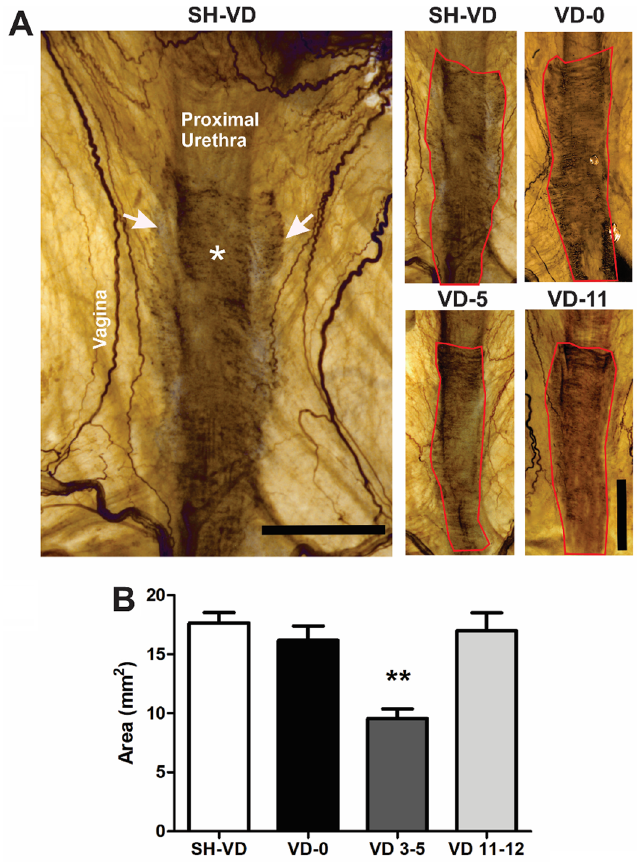
Figure 4. Urogenital tract of rats showing injury and recovery of cholinergic innervation in the urethra after vaginal distension (VD). ( A ) Photos of the urogenital tissue treated with acetylcholinesterase (AchE) histochemistry in a ventral view of urethra from a SH-VD rat, immediately after VD (VD-0), at day 5 (VD-5) or day 11 after VD (VD-11). Red lines illustrate the external urethral sphincter. Asterisk and arrows indicate EUS fibers, both circular and those that attach to the ventral wall of the vagina, respectively. ( B ) Graph of AchE positive areas from SH-VD and VD rats. Values are mean ± standard error of the mean. ** ( p < 0.01) indicates significant differences among VD at day 5 vs SH-VD, immediate VD, and at day 12. One Way ANOVA. Horizontal and vertical scale bars = 2.5